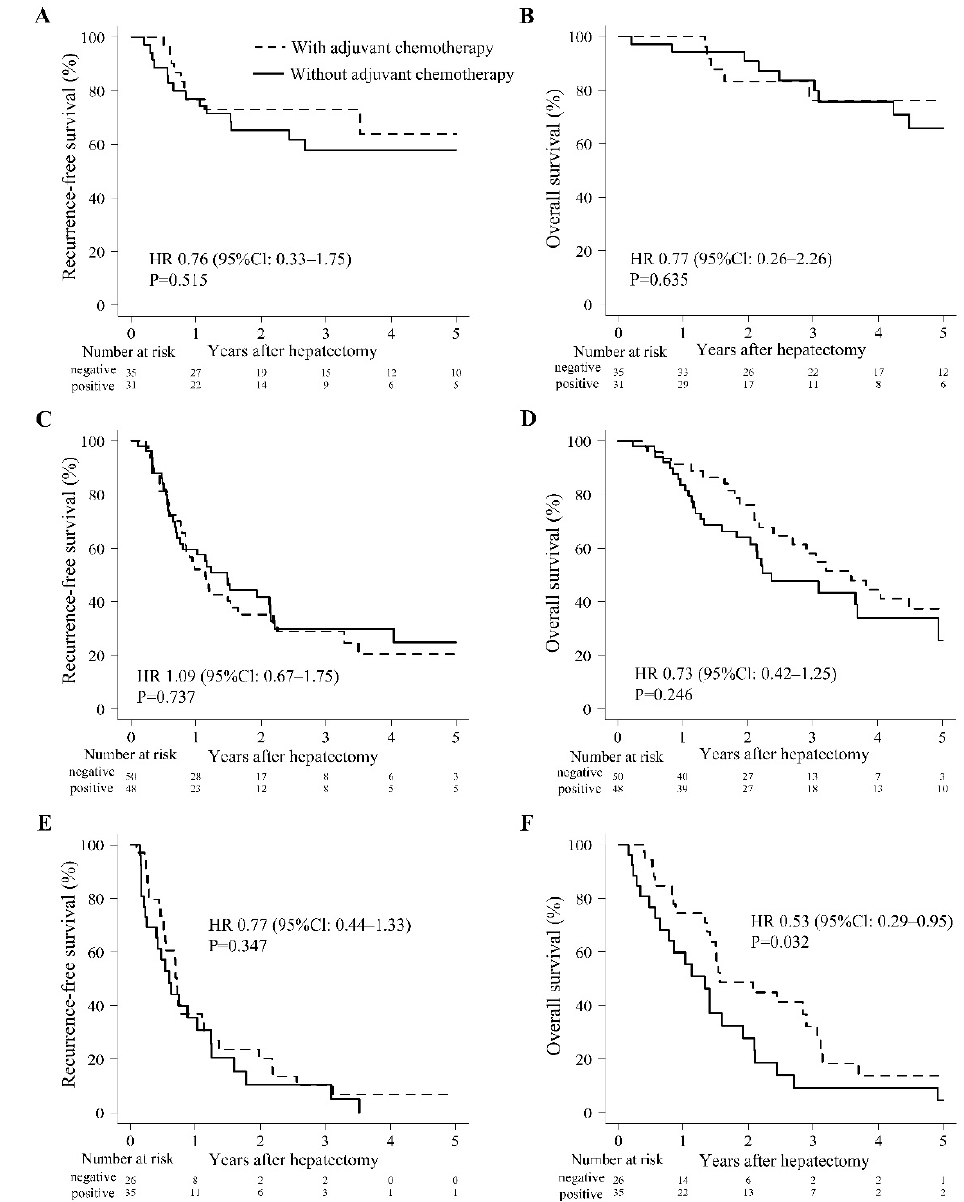
Figure 3. Comparison of survival outcomes after hepatic resection between patients with or without adjuvant chemotherapy. ( A ) Recurrence-free survival in the low-risk group. ( B ) Overall survival in the low-risk group. ( C ) Recurrence-free survival in the moderate-risk group. ( D ) Overall survival in the moderate-risk group. ( E ) Recurrence-free survival in the high-risk group. ( F ) Overall survival in the high-risk group. CI: confidence interval; HR: hepatic resection.